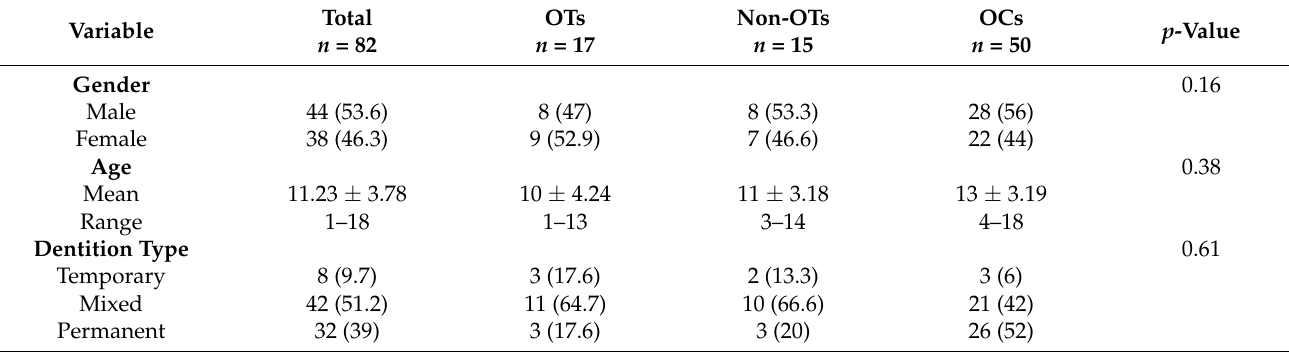
Table 1. Age and gender distribution and dentition type in children and adolescents ( n = 82).